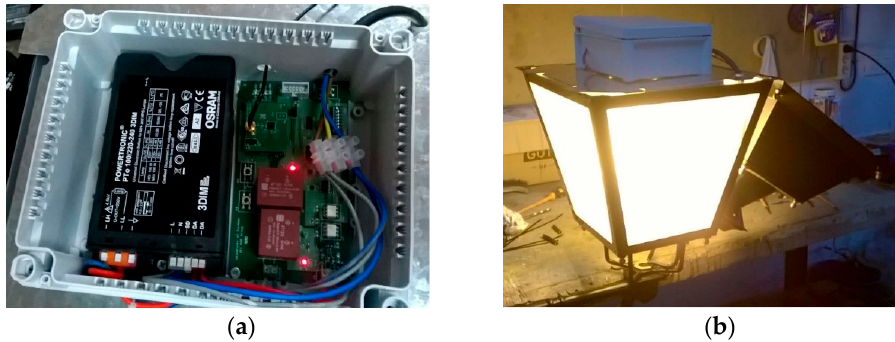
Figure 20. ( a ) Wireless node and ballast; ( b ) Installation of the node into the luminaire.